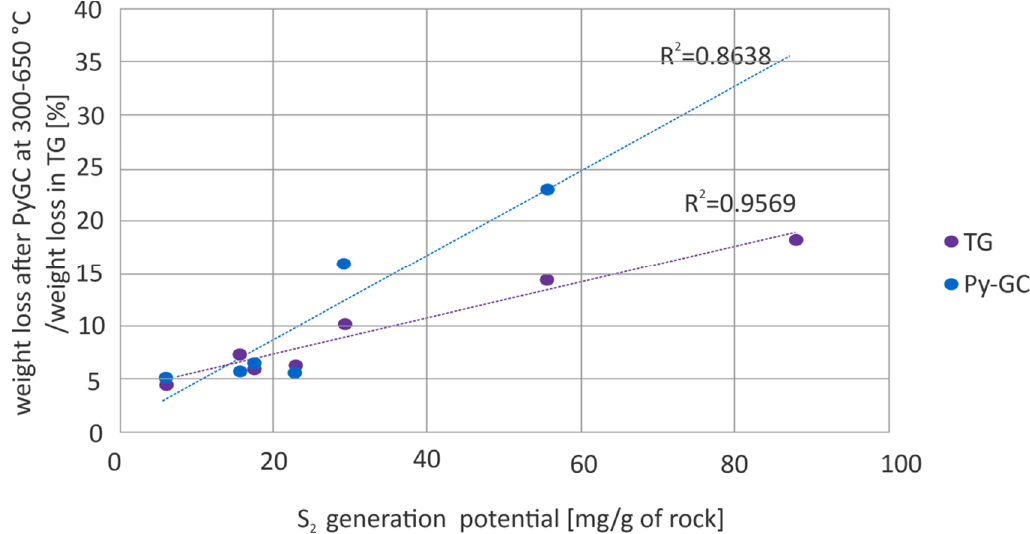
Figure 10. Dependence of weight loss on S 2 generation potential for Menilite samples during Py/GC and TG/DTG pyrolysis at temperatures of 300 to 650 °C.